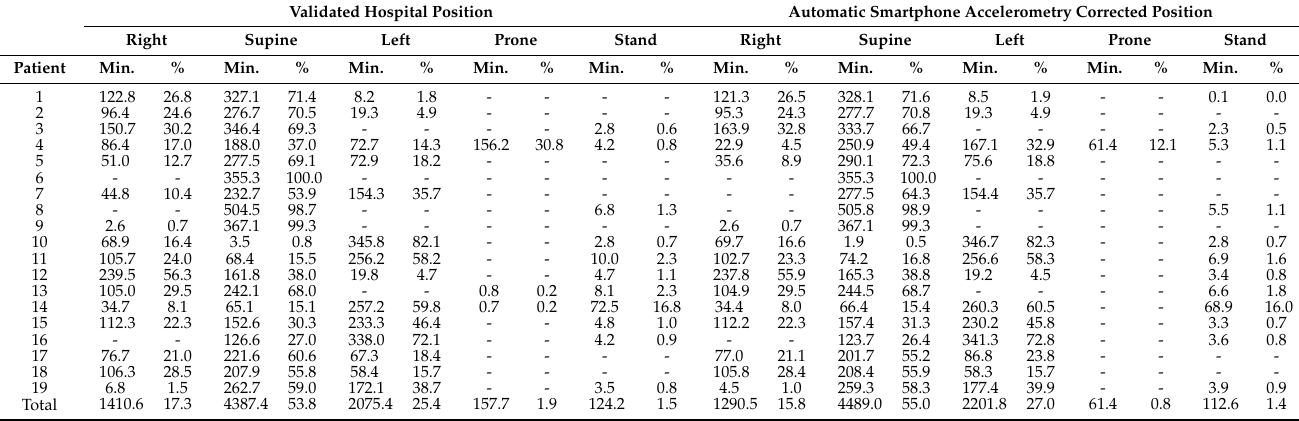
Table 1. Time spent in each position in minutes and as a percentage for both the video-validated PSG and the corrected smartphone positions, for each patient.